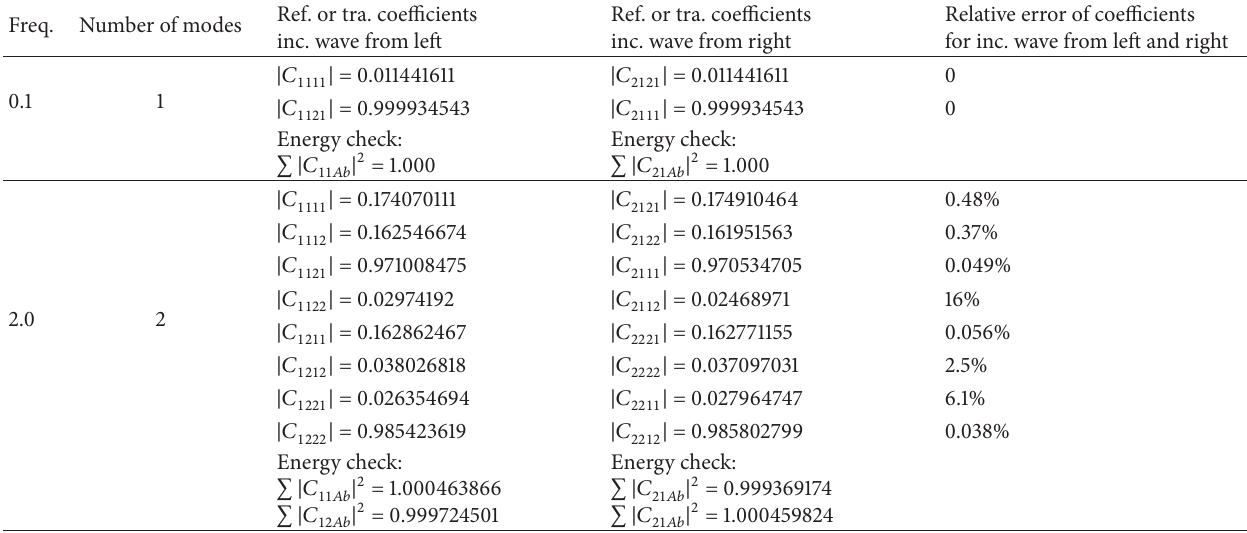
Table 1: An illustration of validation chart for reflection and transmission coefficients.